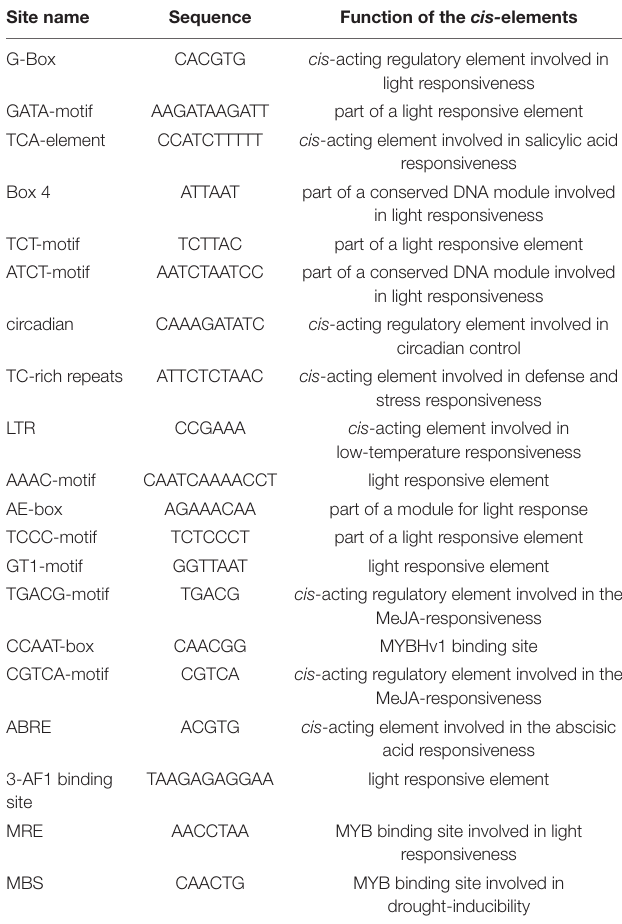
TABLE 2 | The cis- elements have been identified in more than three BnaCOL